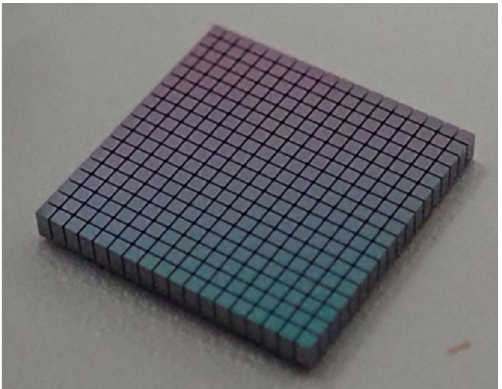
Figure 3. Image of the diced 0.5 mm × 0.5 mm chips, showing perfect dicing without debonding.